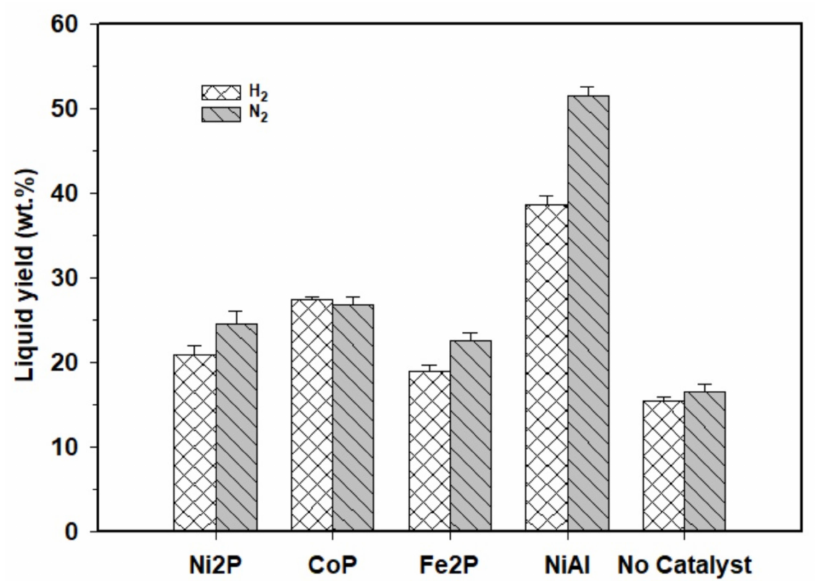
Figure 12. The effects of various gas media (N 2 and H 2 ) on liquid yields produced after 6 h at 300 ◦ C, 2 bars initial pressure, 5 wt% catalyst loading with respect to biomass amount, 2 g biomass, methanol solvent, and 180 µ m biomass particle size.